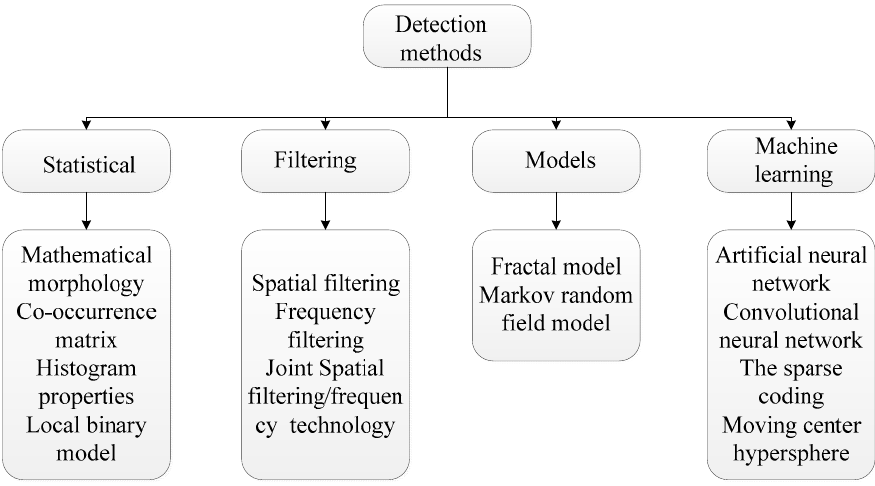
Figure 6. Classification map of steel surface defect detection methods.